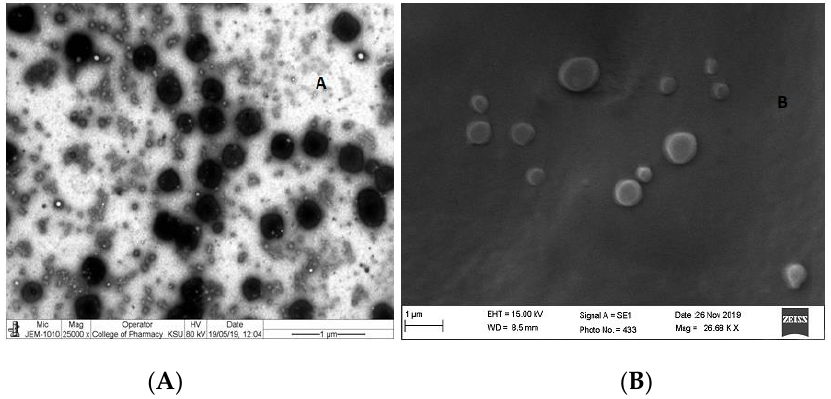
Figure 4. Particlesizedistribution, shape, andmorphologyofCScoatedRES-PLGA-NPs. ( A )Transmission electron microscopy (TEM) image ( B ) SEM